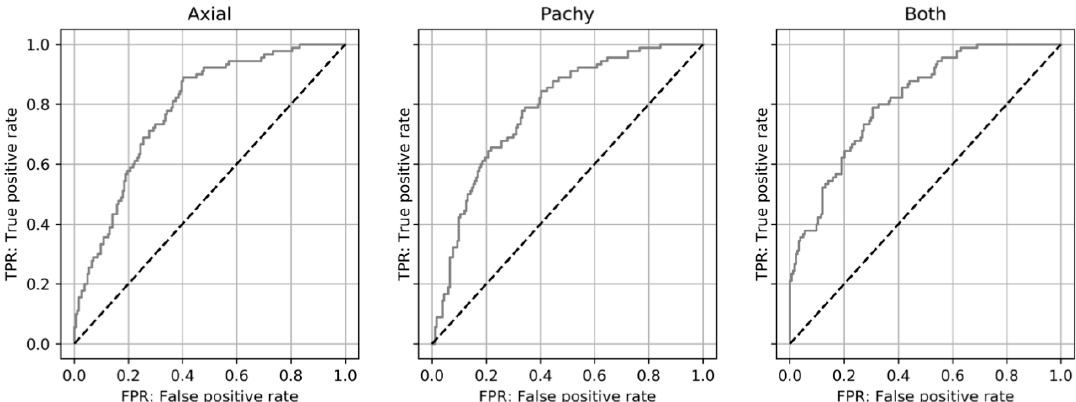
Figure 4. Receiver operating characteristic (ROC) curve of the probability for cross-linking (CXL) among keratoconus eyes. Axial map (Axial), pachymetry map (Pachy), and a combination of the two maps (Both) reveal a similar ROC curve of probability for CXL.